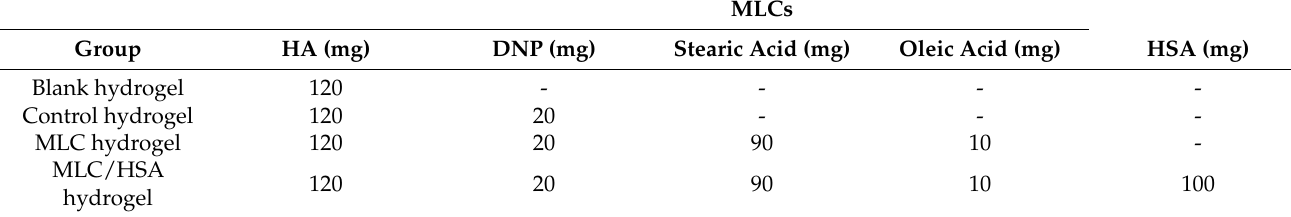
Table 1. Compositions of